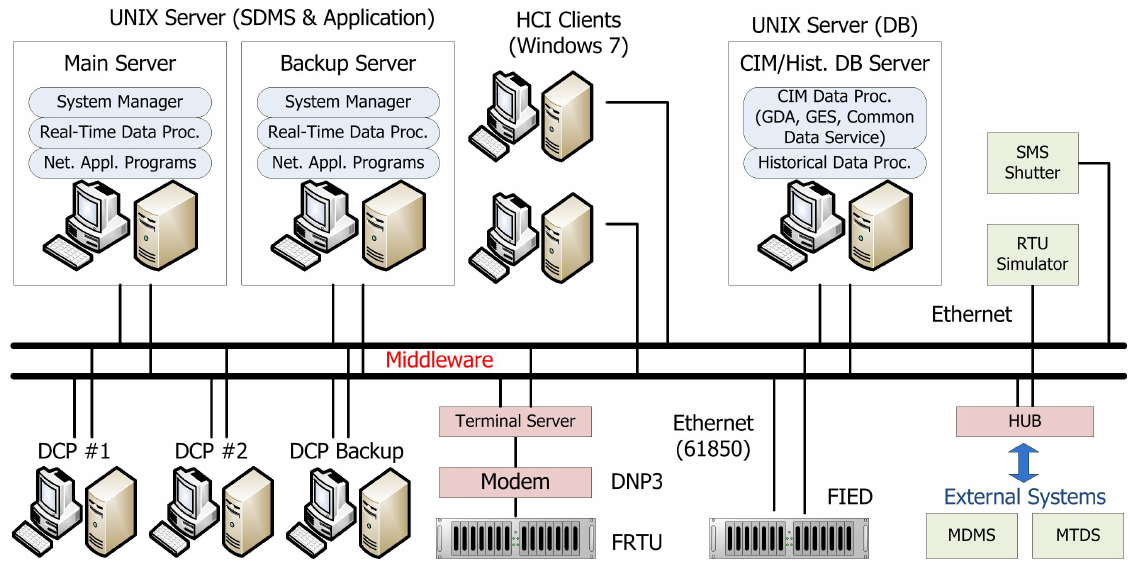
Figure 6. KSDMS platform